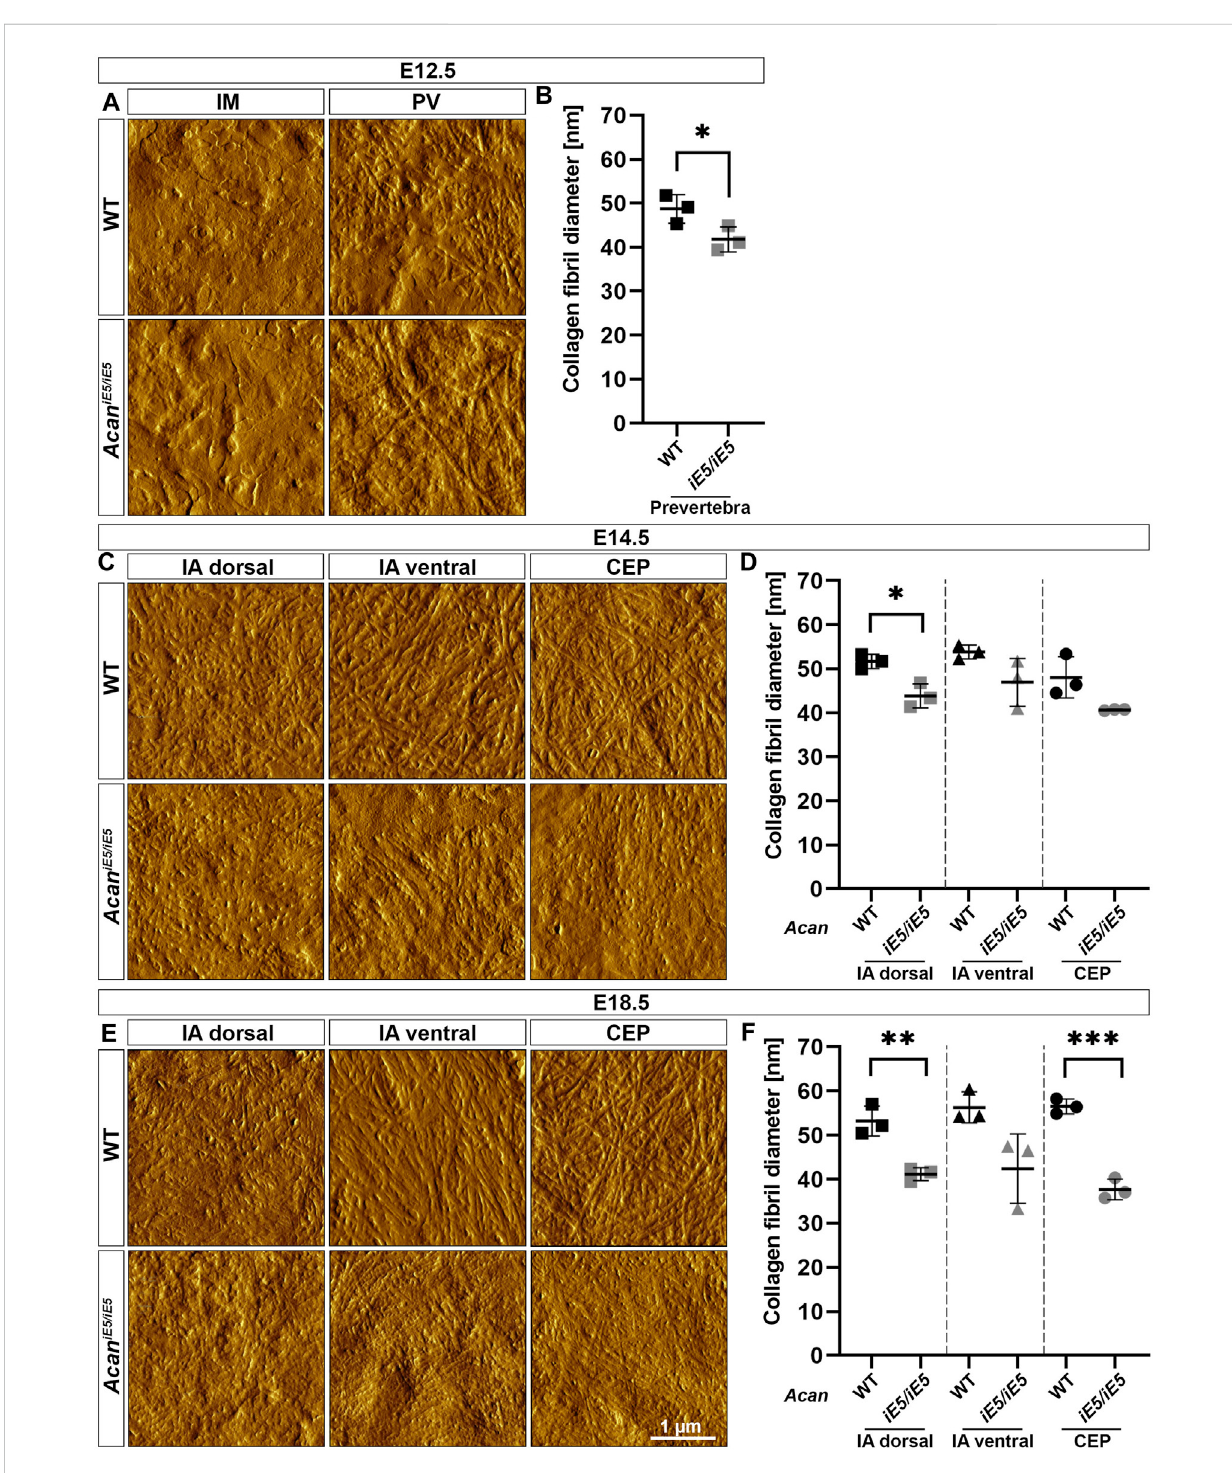
FIGURE 5 Characterization of the collagen network in the developing IVDs of the cervical spine in WT and Acan iE5/iE5 mice. (A, C, E) High-resolution (3 × 3 µm) AFM images of the ECM were acquired in the IM and PV at E12.5, and in the IA dorsal, IA ventral and CEP at E14.5 and E18.5. Scale bar, 1 µm. (B, D, F) Quanti fi cation of collagen fi bril diameter. Bars represent the mean ± STD. At least one AFM image and 50 fi brils were analyzed per independent mouse, n = 3. Statistical signi fi cance calculated by t -test where * p < 0.05; ** p < 0.01; *** p < 0.001.